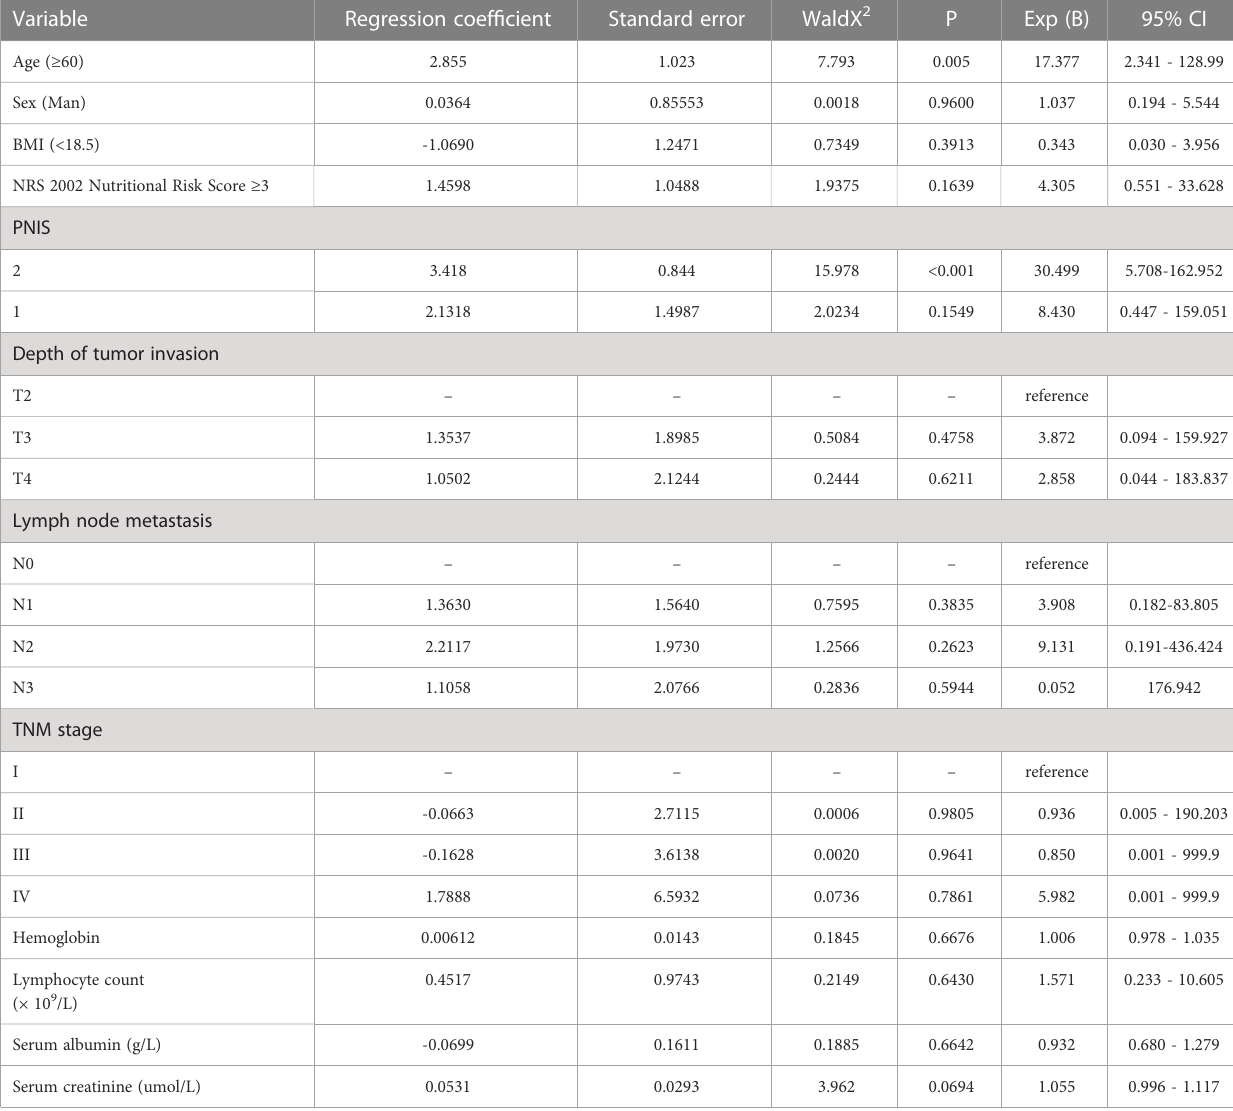
TABLE 4 Multiple logistic regression analysis of postoperative complications in locally advanced gastric